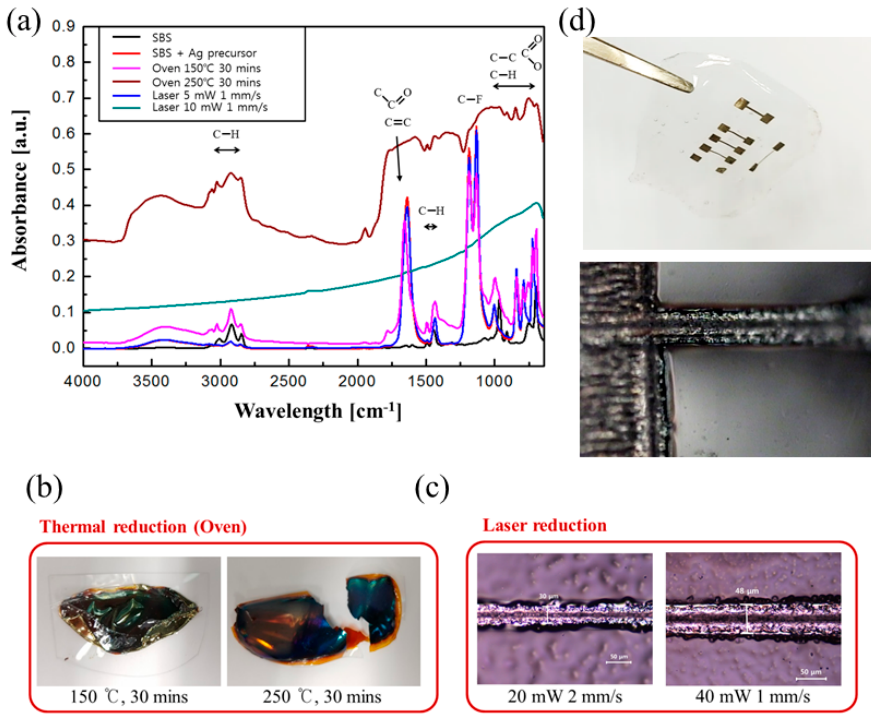
Figure 2. FTIR spectra of SBS (black), composite SBS (red), Ag precursor thermally reduced in an oven at 150 ◦ C (pink) and 250 ◦ C (brown) for 30 min, Ag precursor reduced using a laser at a laser power of 5 mW (blue) and 10 mW (bluish green) at a scan speed of 1 mm s − 1 ( a ). Thermal heating of composite SBS in the oven at 150 ◦ C and 250 ◦ C for 30 min ( b ). Optical images of top view of the electrode line after laser irradiation on composite SBS ( c ). Fabricated electrodes with various line widths (30–400 µ m) by laser reduction ( d ).